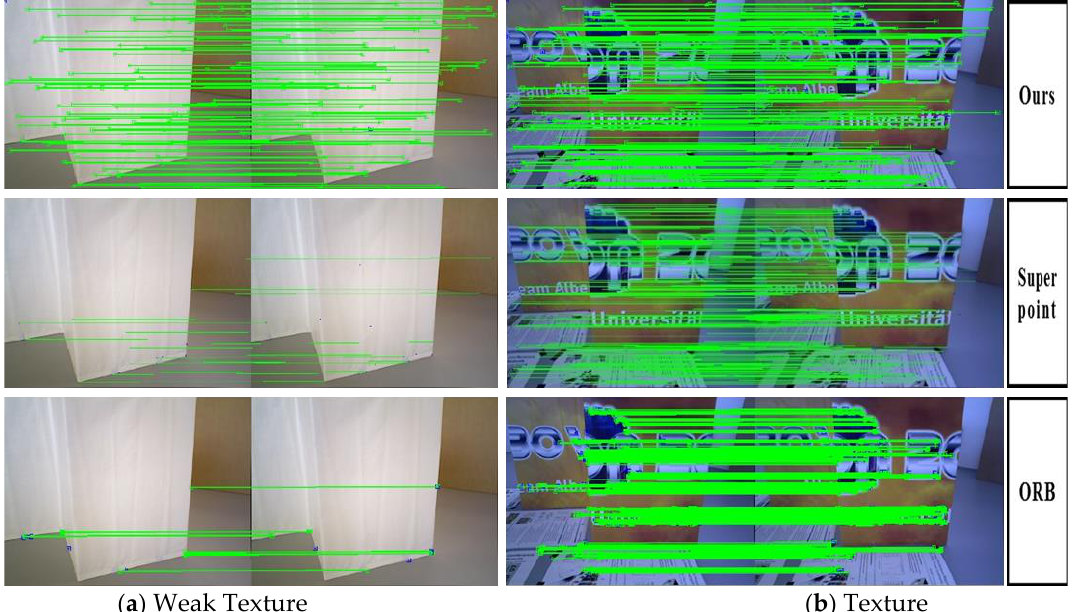
Figure 8. Feature point matching and comparison on texture.